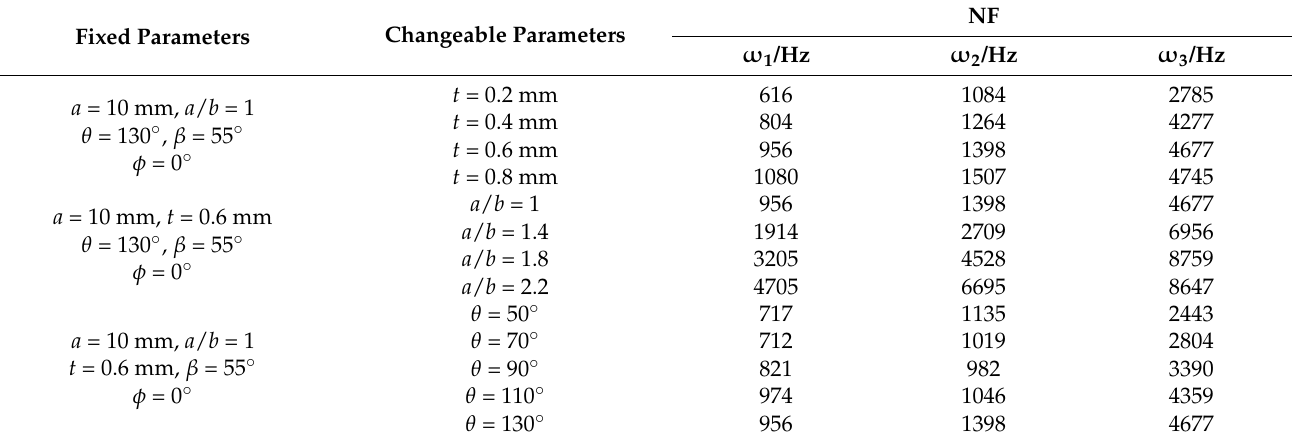
Table 2. Numerical simulation results of NF of the Miura